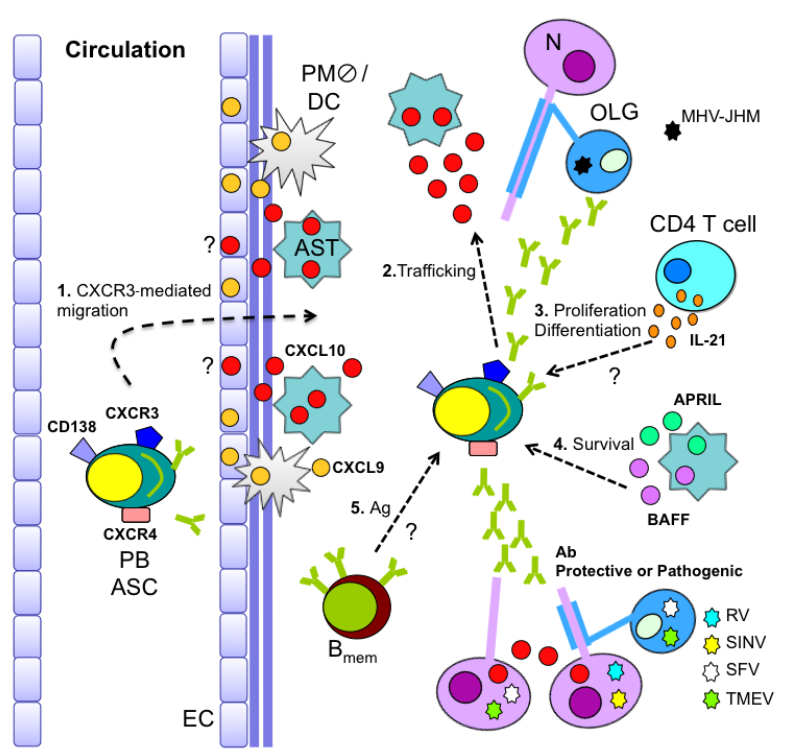
Figure 3. CNS B cell recruitment/maintenance during glia-tropic MHV infection. Recruitment of circulating antibody-secreting cells (ASC) into the CNS is CXCR3 dependent (1). While CXCL9 and CXCL10 presentation at the microvasculature may promote initial ASC recruitment, astrocyte-derived CXCL10 mediates ASC entry and parenchymal localization (1 and 2). ASC proliferation/differentiation may be aided by CD4 T cell-derived IL-21 (3). Moreover, sustained elevated expression of astrocyte-derived BAFF and APRIL provides a local niche supporting ASC survival (4). Memory B cell (B ) recruitment and antigen (Ag)-driven differentiation in the inflamed mem CNS may further contribute to the local ASC population (5). PB = plasma blast; EC = endothelial cell; AST = astrocyte; DC = dendritic cell; PM  = perivasacular macrophage; N = neuron; OLG =